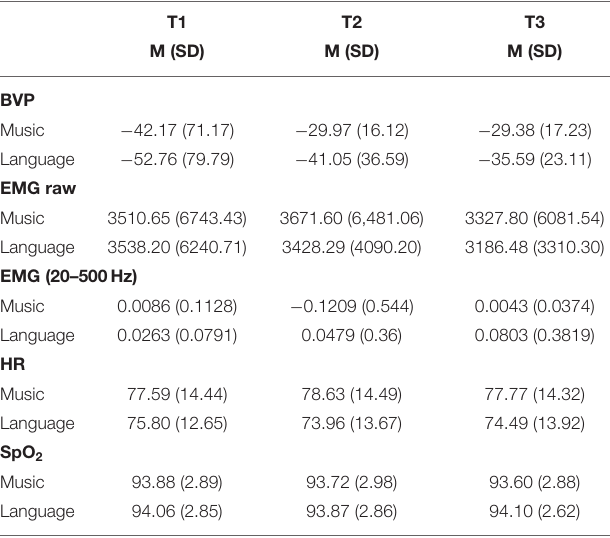
BVP, blood volume pulse, relative blood flow in millivolts; EMG, electromyography in microvolts ( µ V pk-pk); HR, heart rate in beats per minute; SpO 2 , oxygen saturation measured by a finger pulse oximeter in